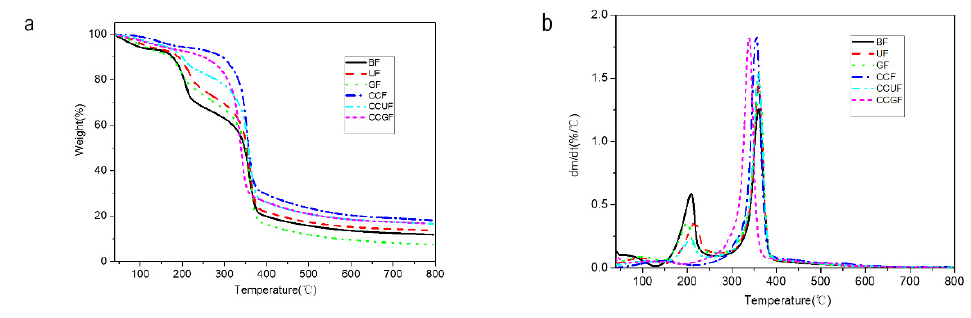
Figure 6. TGA curves ( a ) and DTG curves ( b ) of the regenerated cellulose fibers with or without additives. Table 5. Thermal properties of the regenerated cellulose fibers after different stage of